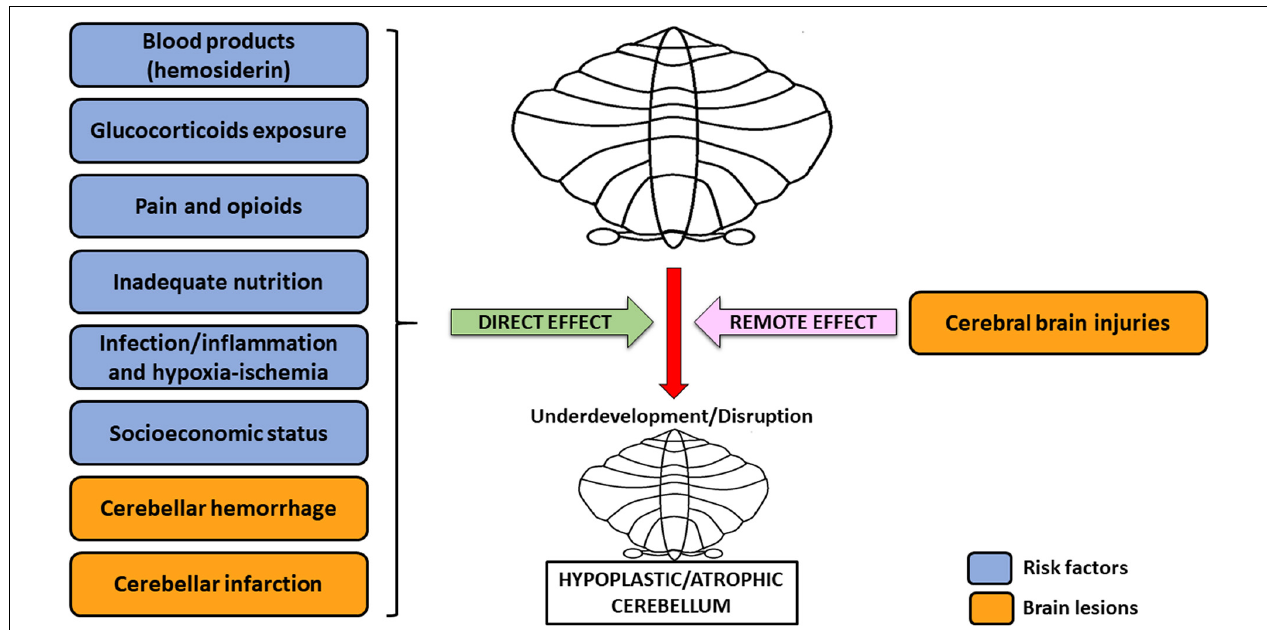
FIGURE 1 | Risk factors and brain lesions leading to cerebellar underdevelopment/disruption. The risk factors nowadays acknowledged for cerebellar underdevelopment/disruption are: blood products (hemosiderin), glucocorticoids exposure, pain and opioids, inadequate nutrition, infection/inflammation, and hypoxia-ischemia. All of these, together with cerebellar hemorrhage and infarction (possible injuries affecting the cerebellum), usually act through a direct effect, potentially leading to cerebellar hypoplasia/atrophy. However, this latter condition may also be the result of cerebral brain injuries, which cause dysfunction in a distant, though neurally connected area of the brain, i.e., the contralateral cerebellum (remote effect) (Volpe, 2009; Pierson and Al Sufiani,